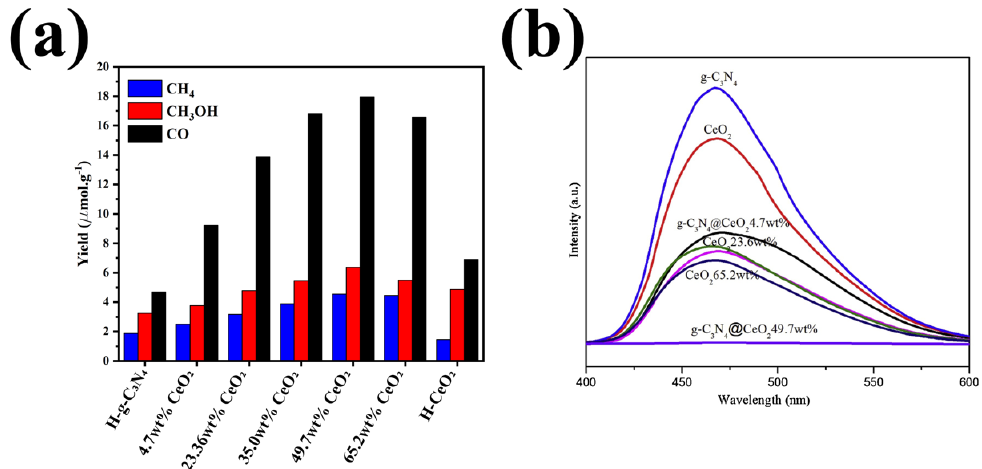
Figure 18. ( a ) Hydrocarbon generation of hollow g-C 3 N 4 (H-g-C 3 N 4 ), hollow CeO 2 (H-CeO 2 ), and g – C 3 N 4 @CeO 2 for 4 h illumination; ( b ) photoluminescence emission spectra of H-g – C 3 N 4 , H-CeO 2 ref- erences, and g-C 3 N 4 @CeO 2 heterojunction with different ratios. Copyright © 2022 Elsevier [435]. Other researchers also work on the CO 2 reduction of g-C 3 N 4 – metal oxide-based pho- tocatalysts, which is listed in Table 3.